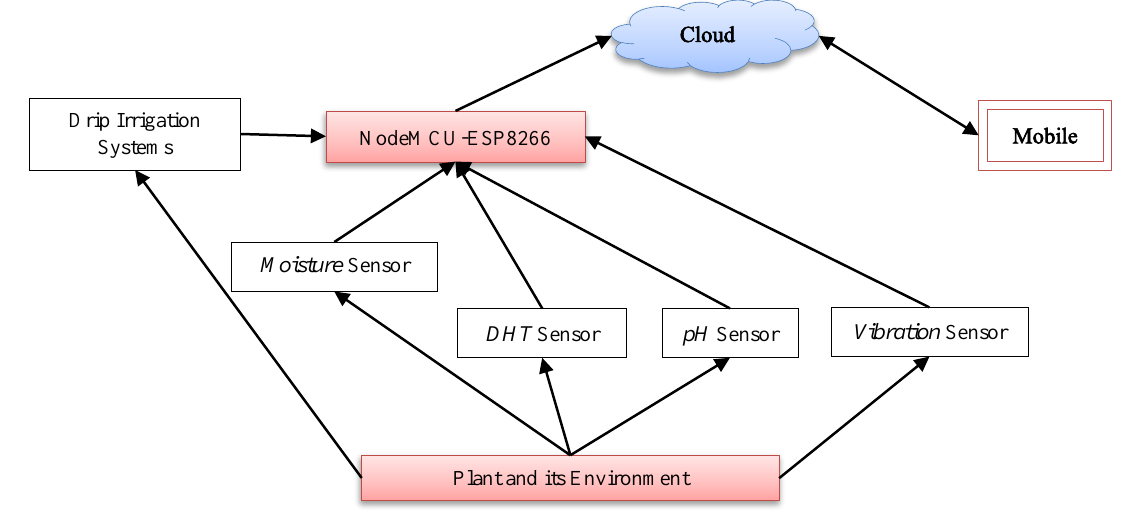
Figure 9. Proposed health monitoring